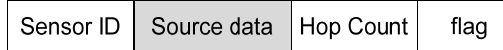
Figure 7. Packet header